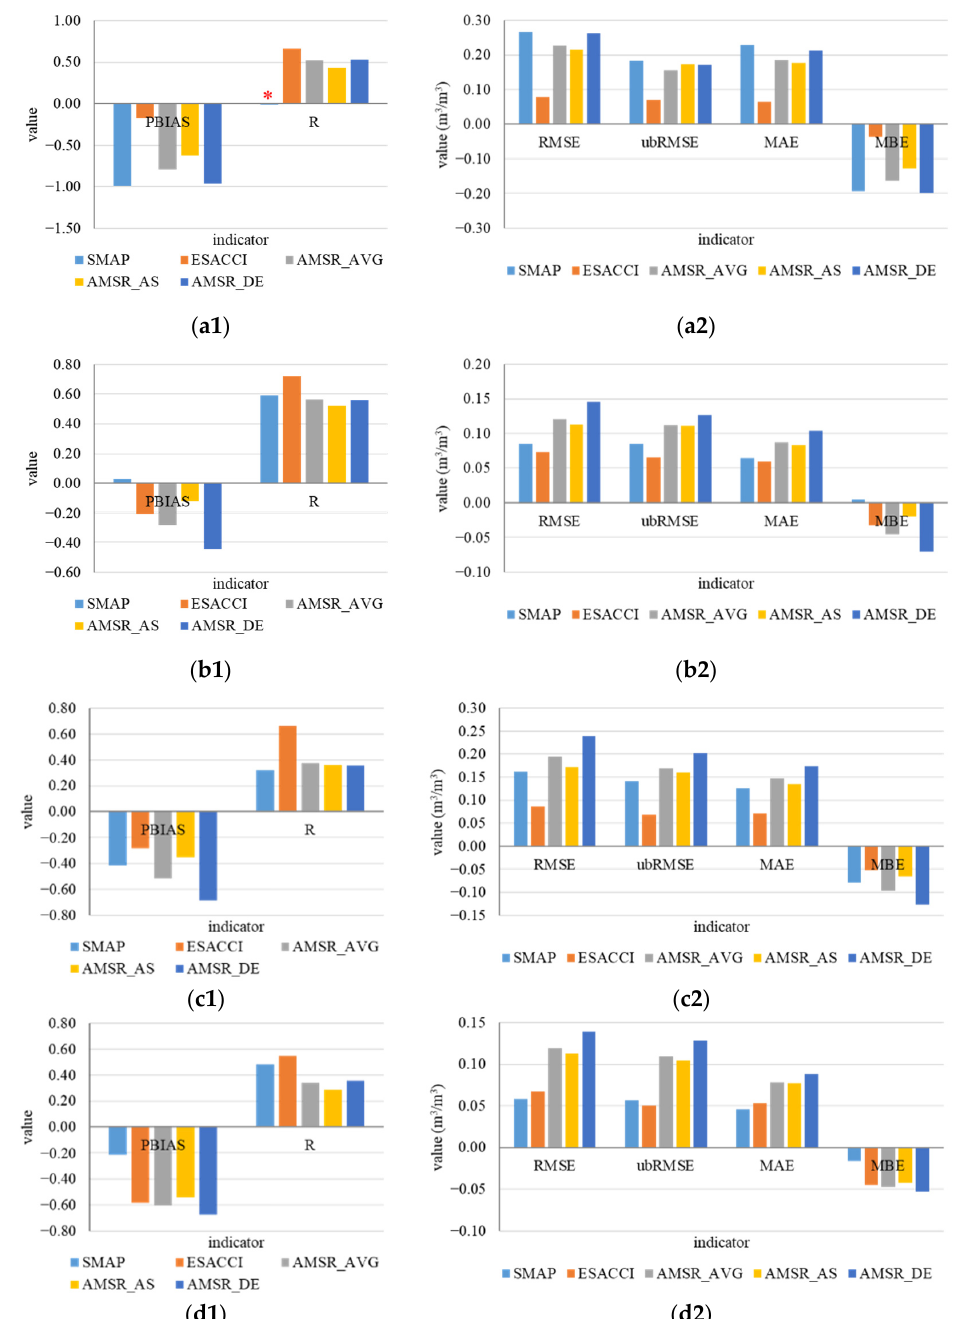
Figure 7. Performance of land cover types at monthly scale (for R, p -value < 0.0001; except R of SMAP in subplot ( a1 ) marked with red asterisk, its p -value was 0.78 with no significance). ( a1 , a2 ): forests; ( b1 , b2 ): grasslands and shrublands; ( c1 , c2 ): savannas; and ( d1 , d2 ): barren and sparse vegetation.